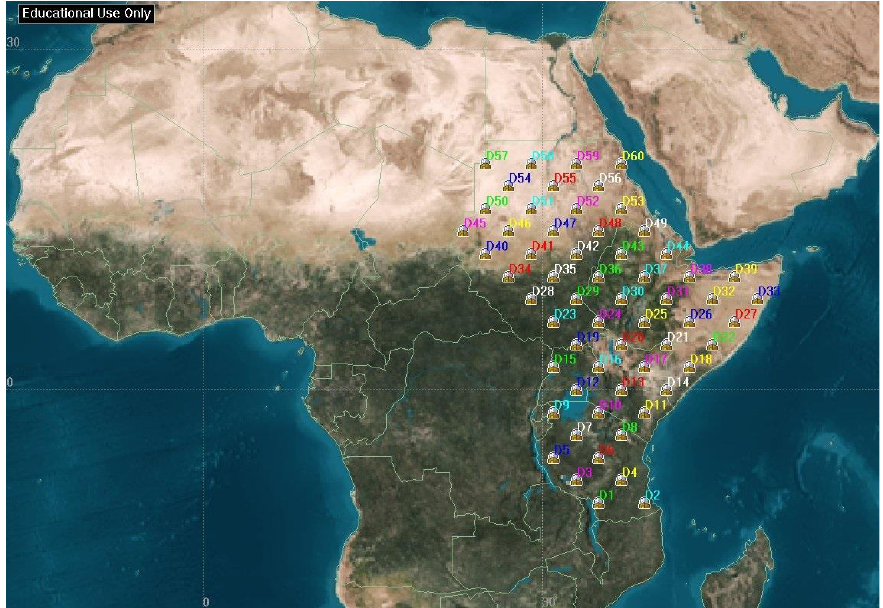
Figure 2. Regional data collection centers, evenly distributed over the target area.